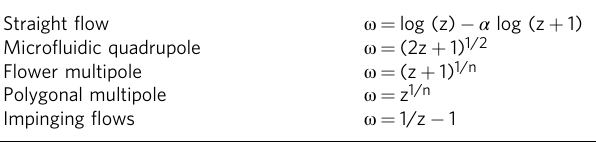
Table 1 Examples of simple transforms that can be applied to the dipole solution to obtain new